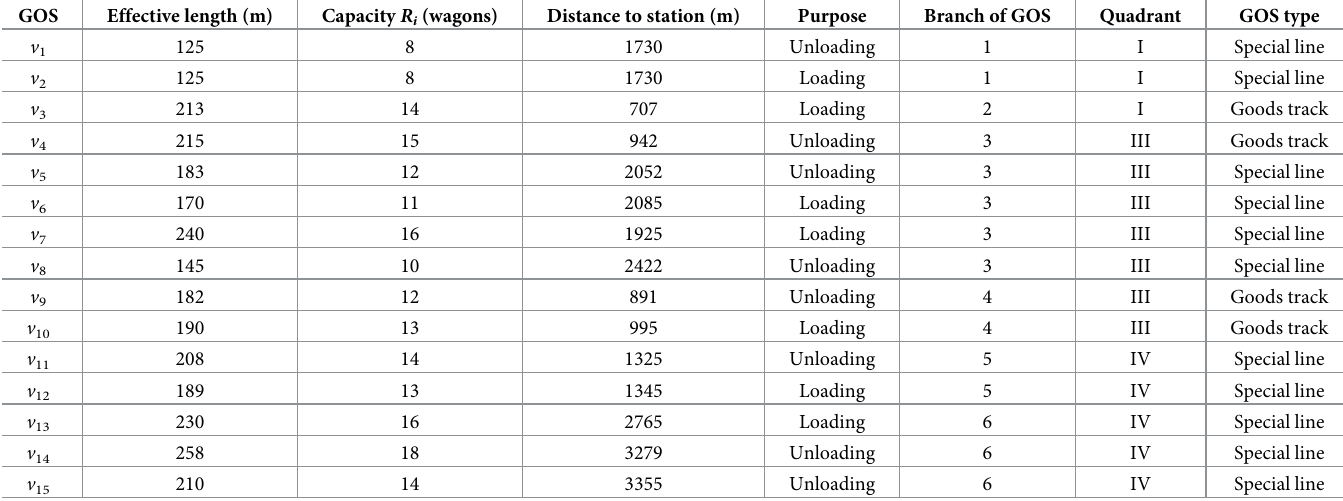
Table 1. GOSs of the experimental